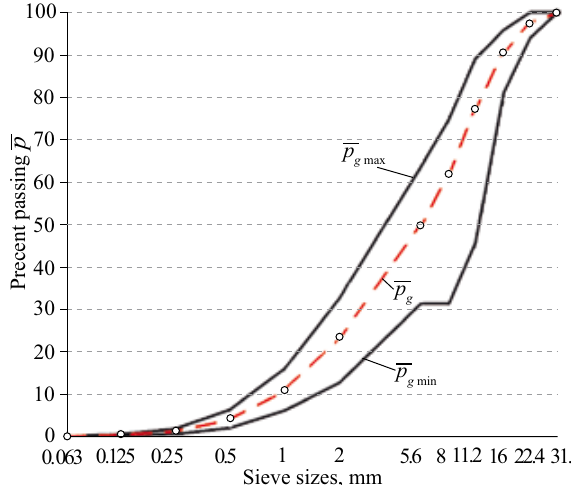
Fig. 2. Gradation of non-extracted granules of milled AP being recycled (RAP-3) (sample size n =